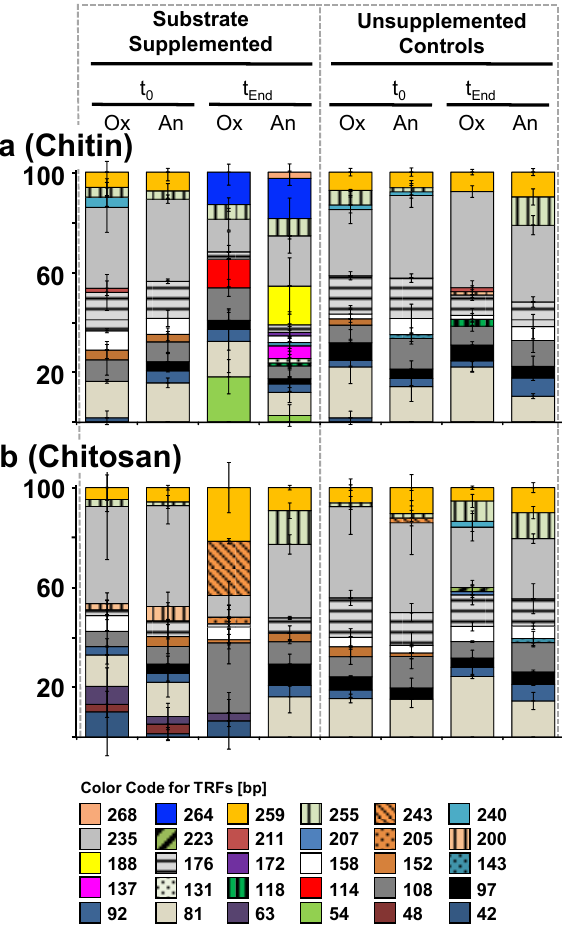
Figure 3. chiA TRFLP patterns of chitin (a) and chitosan (b) supple- mented soil slurries. The corresponding process data are presented in Figs. 1 and 2. In each panel the first four bars represent sam- ples from slurries with substrate and the next four samples from a control experiment without substrate supplementation. Within, the order is as follows: t 0 oxic, t 0 anoxic, t END oxic, and t END anoxic. t END was at 41 days. Experimental replicates were analysed, i.e., each value of a TRF is based on three DNA extracts ( n = 3). Errors bars, standard